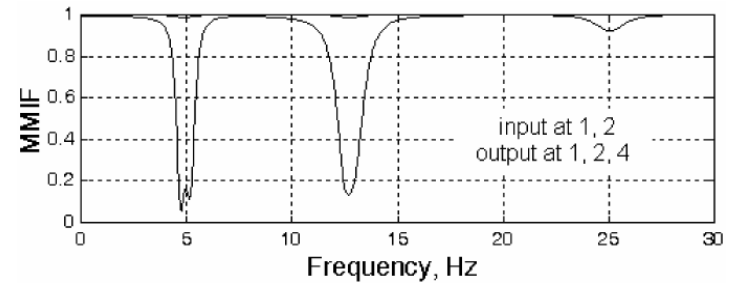
Fig. 5. MMIF for the 5-dof system, case